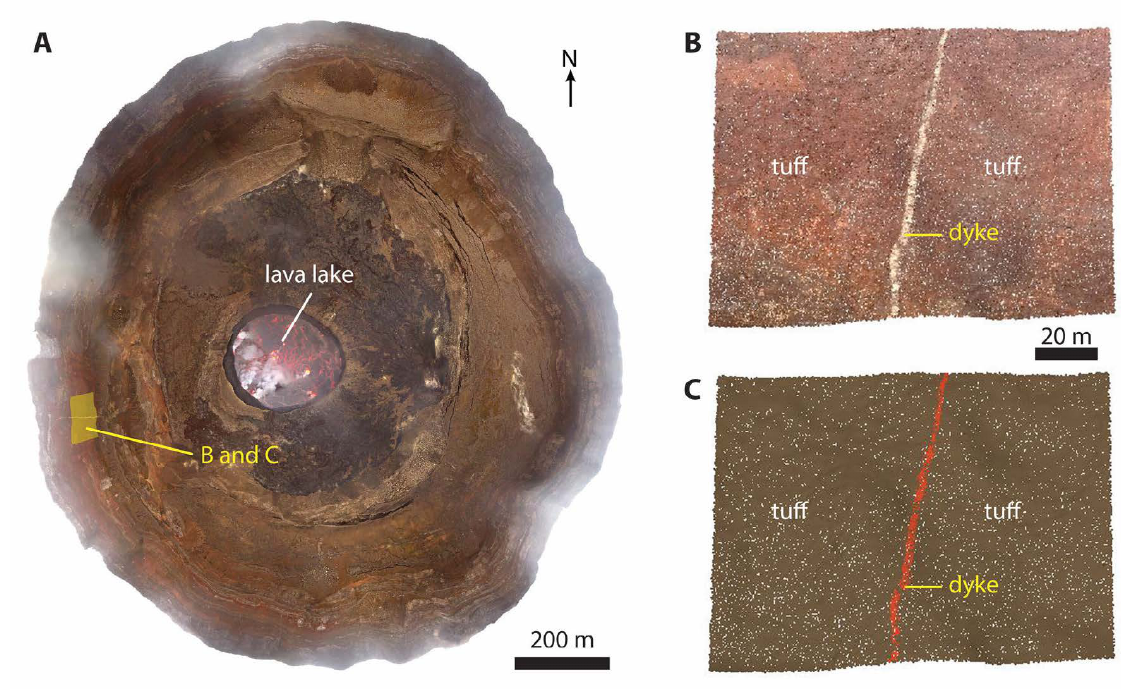
Figure 9: Example of dyke mapping on the SW inner flank of the Nyiragongo main crater, D. R. Congo, using RGB-based classification. Images collected by a DJI Phantom 4 quadcopter, with a ground sampling distance of ~10 cm. [A] Orthophoto of the main crater (August 2016), with the location of the target area shown in B and C. 3-D point cloud of the target area, [B] in true-colour and [C] classified into volcanic tu ff (brown) and the nephelinite dyke